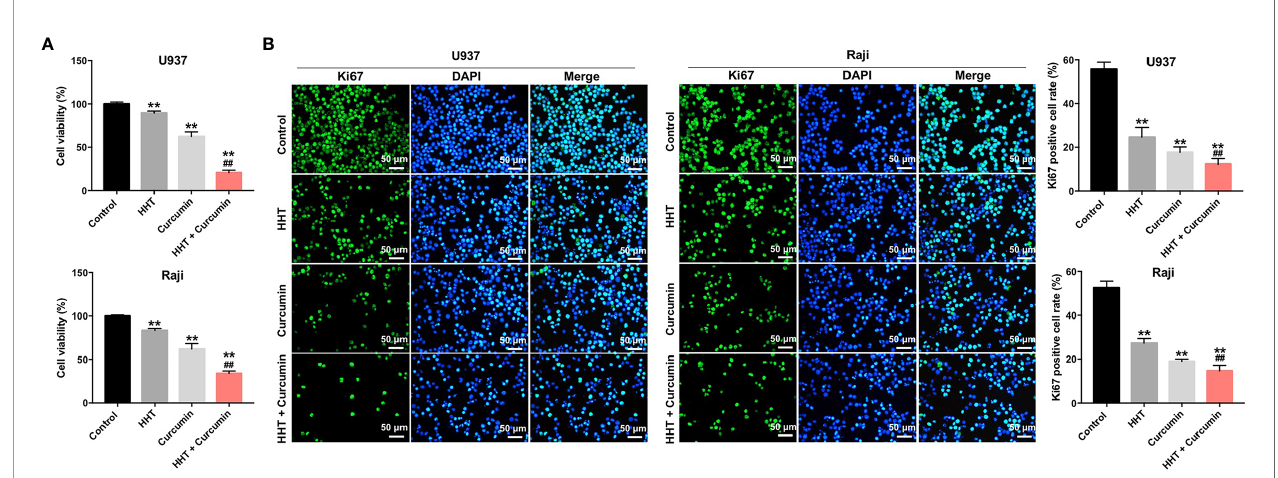
FIGURE 1 | Combination of curcumin with HHT inhibited the proliferation of lymphoma cells. U937 and Raji cells were treated with 5 ng/mL HHT or/and 10 m M curcumin for 72 h. (A) CCK-8 assay was used to detect cell viability. (B) Relative fl uorescence expression levels were quanti fi ed by Ki67 and DAPI staining. **P < 0.01 compared with control group; ## P < 0.01 compared with HHT